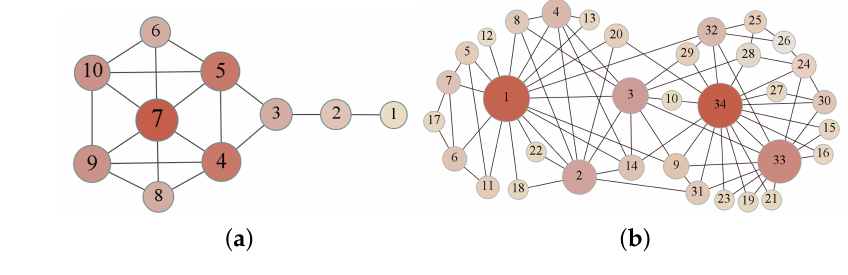
Figure 5. Two small-scale networks. Table 5. The top 10 nodes of Kite and